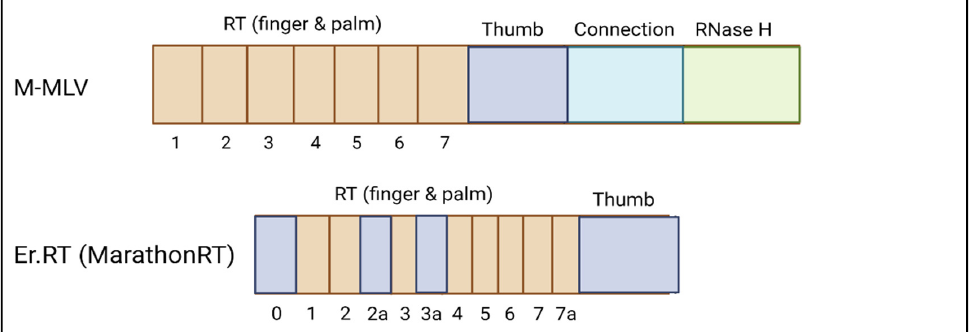
Figure 6. Comparison of the M-MLV and Er.RT structures, A Conceptual structure of the Murine Moloney Leukaemia virus reverse transcriptase with finger and palm domains, thumb, connection and RNase H domains. B One of the smallest reverse transcriptase enzymes derived from Eubacterium rectale that lacks the connection and Rnase H domains Created with BioRender.com (accessed on 23 August